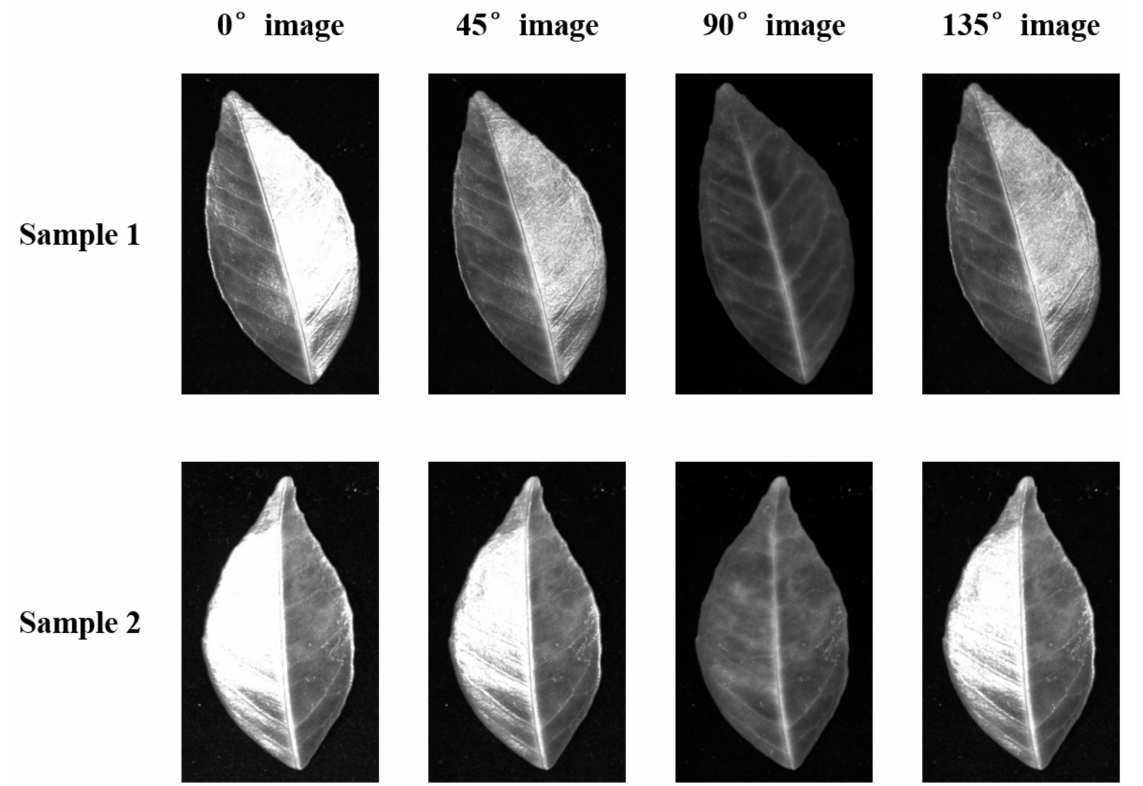
Figure 1. Examples of four polarization angle images acquired in reflection imaging